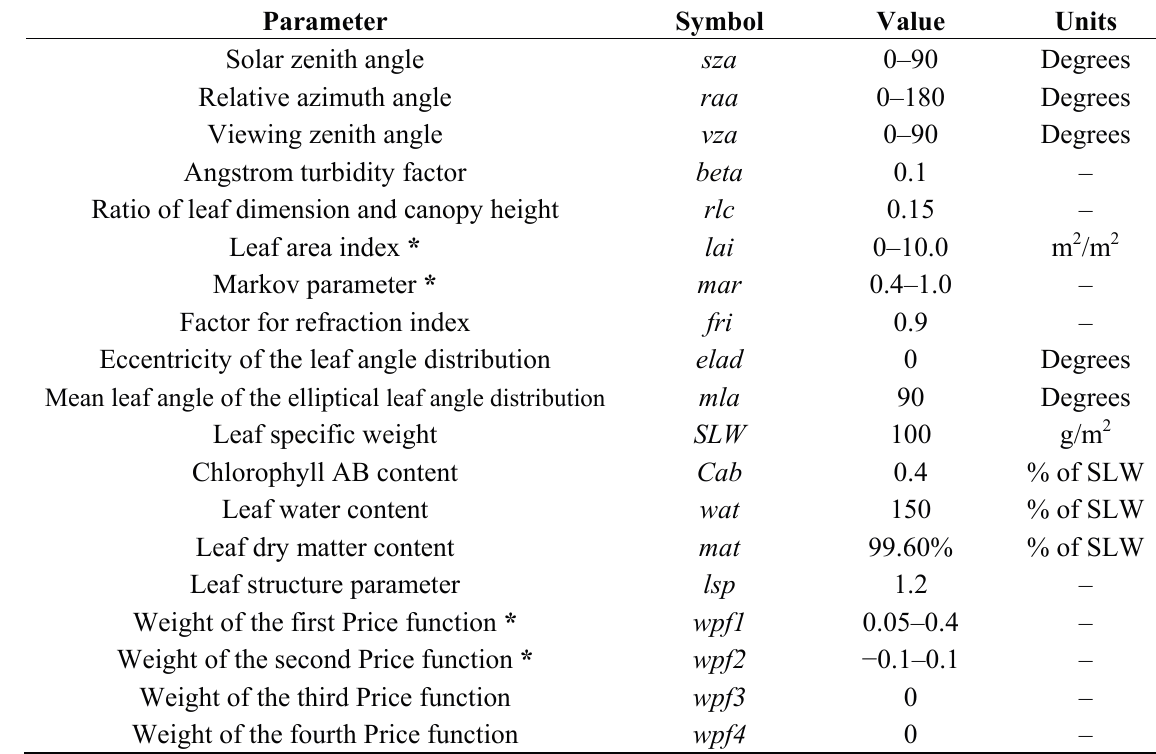
Table 1. Parameters needed to run the two-layer Analytical Canopy Reflectance Model